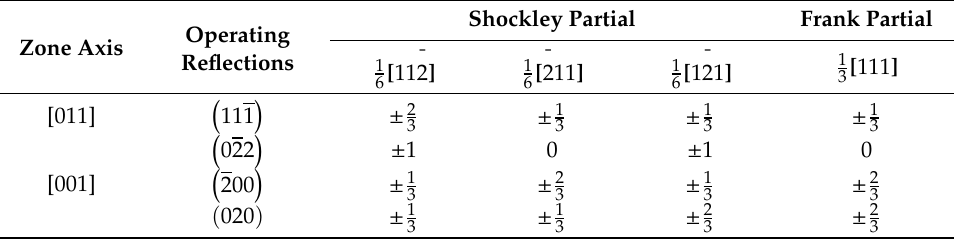
Table 3. Visible / invisible conditions according to g · b results of partial dislocation.